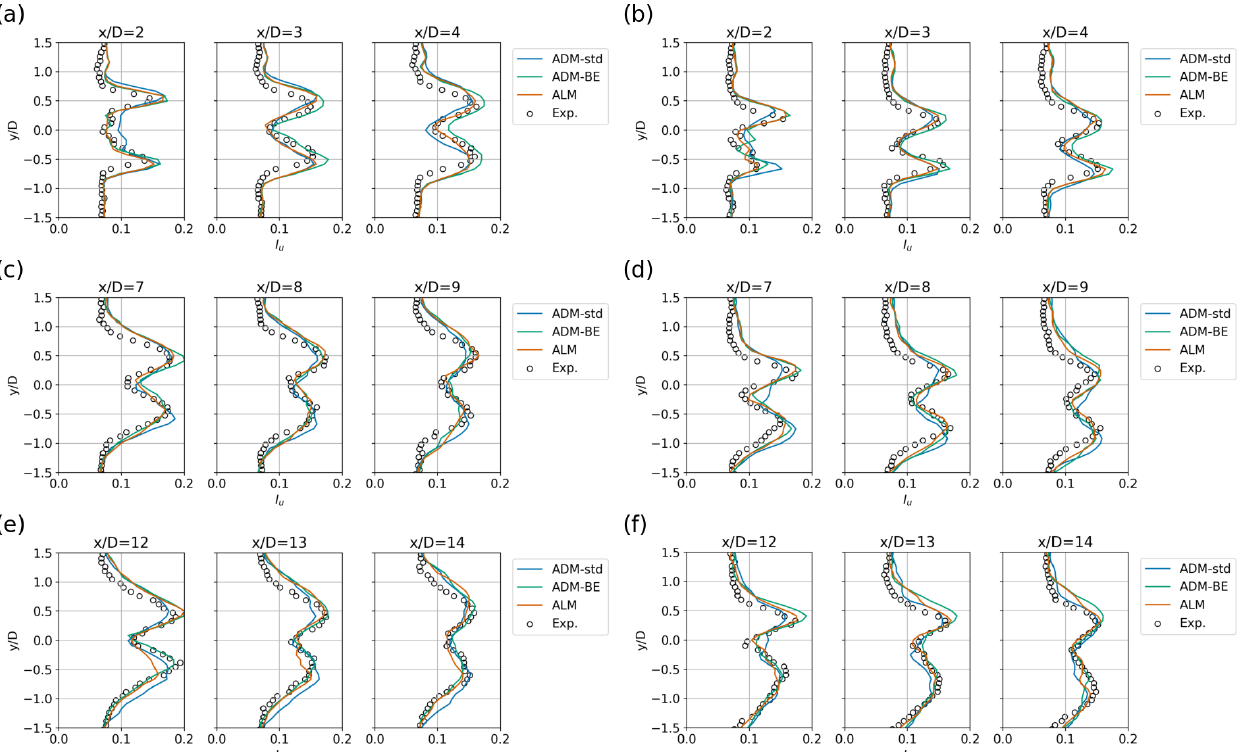
Figure 11. Profiles of the streamwise turbulence intensity I u in the x − y plane at hub height obtained from the wind-tunnel experiments and LES using the ADM-std, ADM-BE and ALM. (a) WT 1, γ = (0 , 0 , 0 ◦ ); (b) WT 1, γ = (25 , 15 , 0 ◦ ); (c) WT 2, γ = (0 , 0 , 0 ◦ ); (d) WT